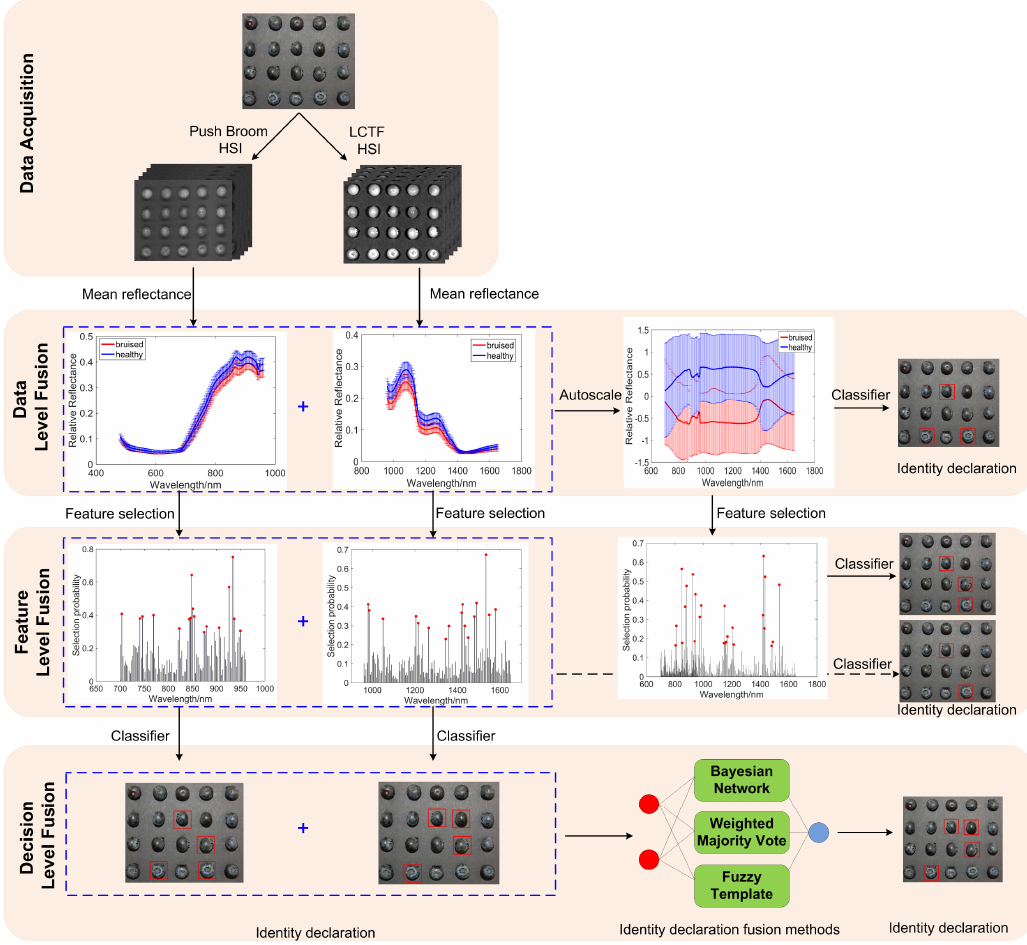
Figure 2. Data fusion processing pipeline.